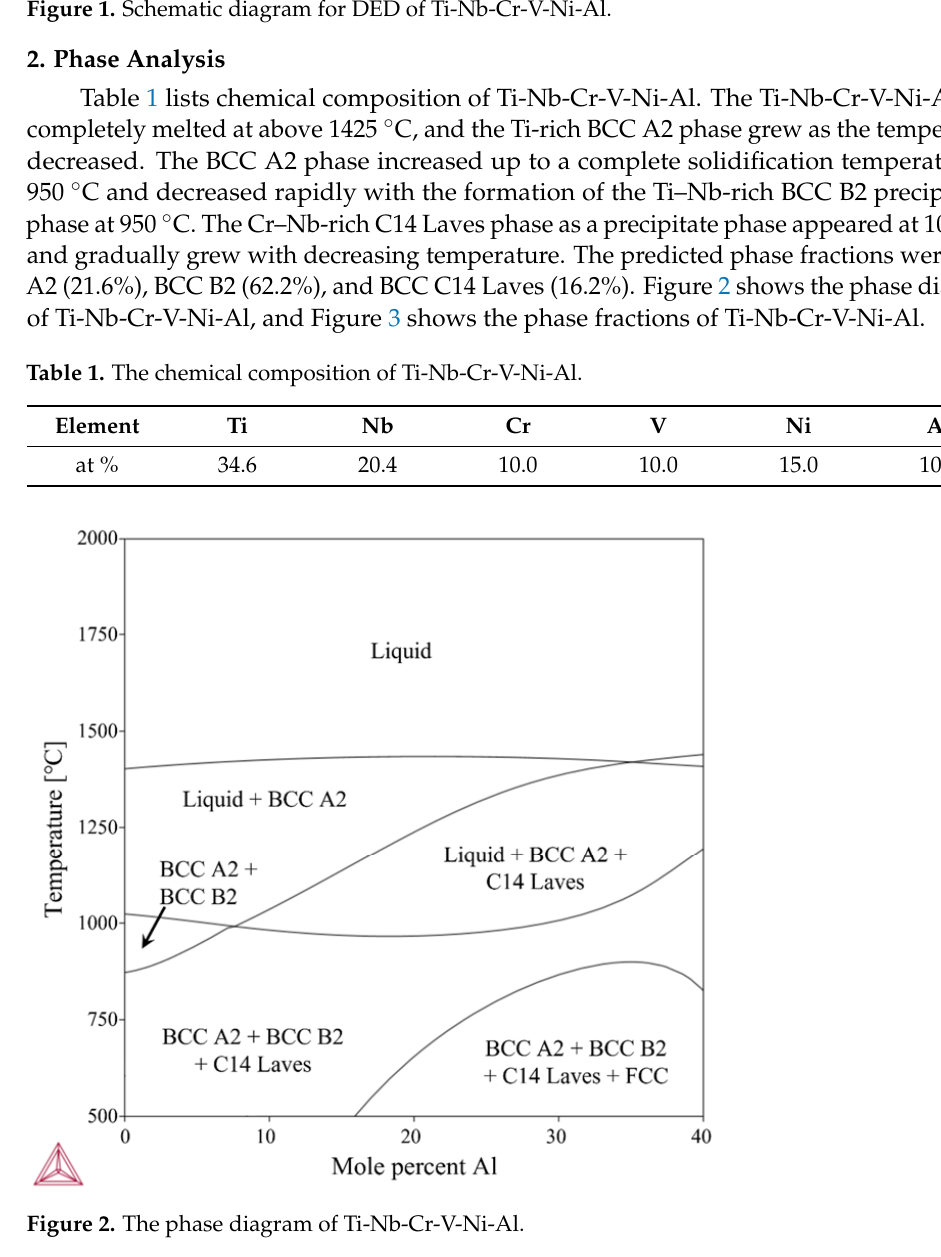
Figure 3. The phase fractions of Ti ‐ Nb ‐ Cr ‐ V ‐ Ni ‐ Al.